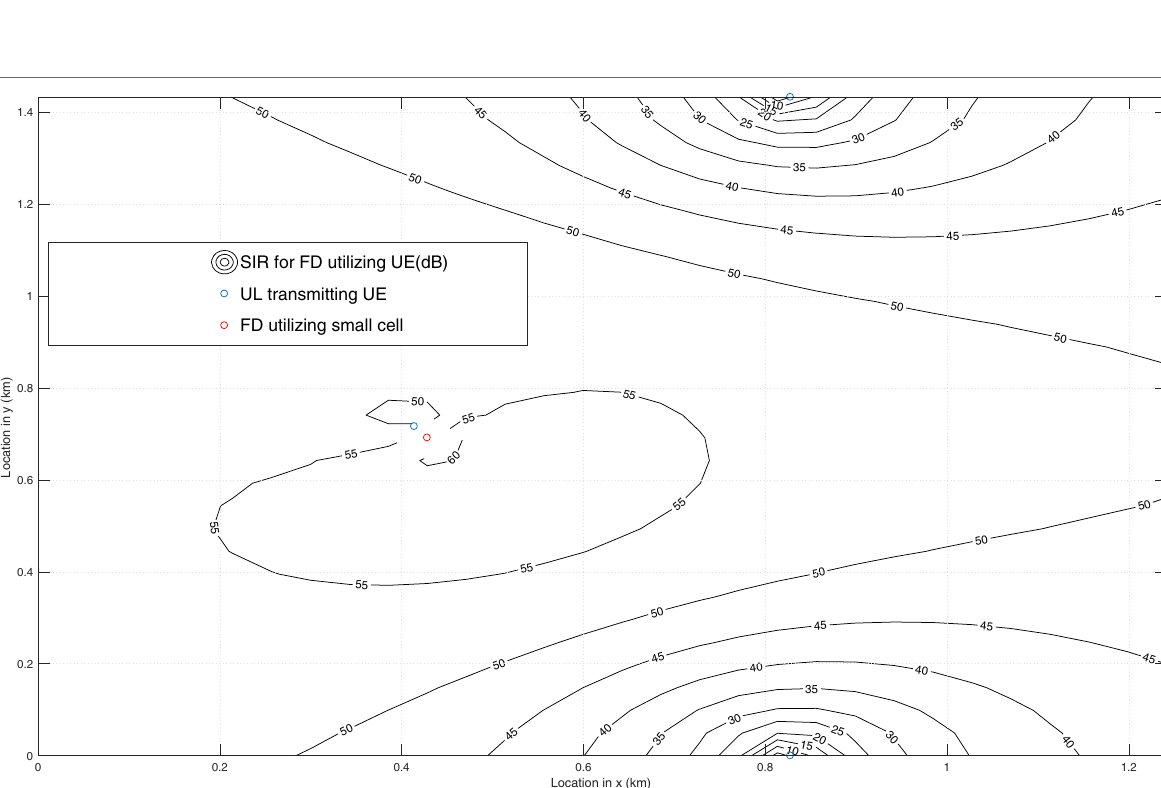
Fig. 12 Calculated signal-to-interference ratio at MT RX in case of nearby UL transmission—3 MTs